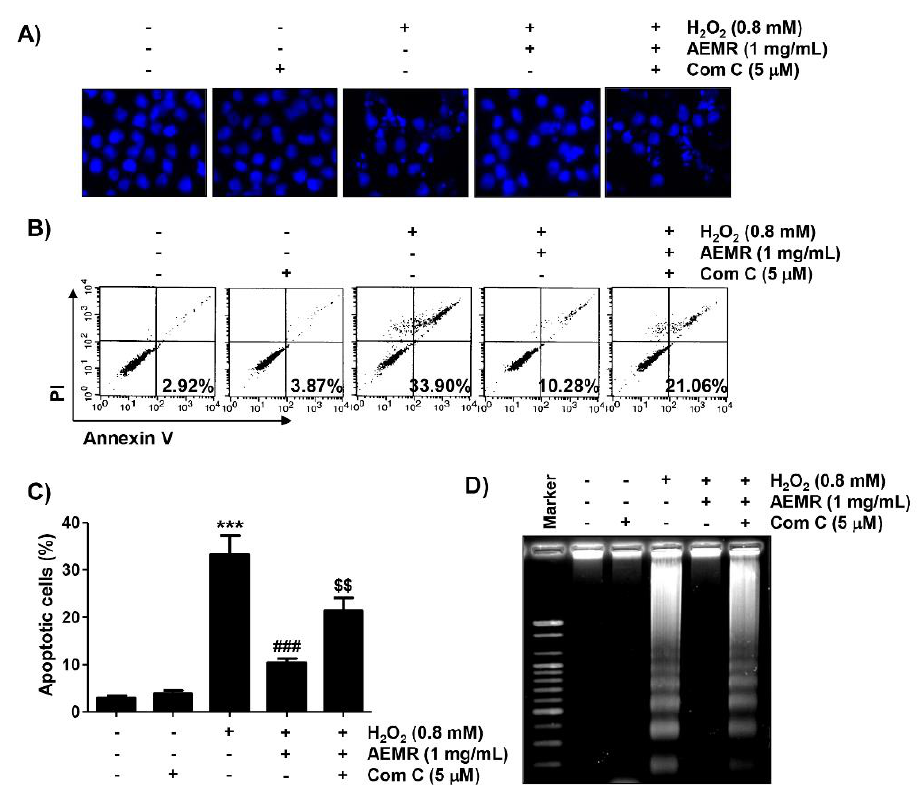
Figure 6. Effect of HO-1 inhibitor on AEMR-mediated protection of apoptosis by H 2 O 2 in C2C12 cells. Cells were pretreated with 5 μM compound C with or without 1 mg/mL AEMR for 1 h, and then treated with 0.8 mM H 2 O 2 for 24 h. ( A ) Induction of apoptosis was evaluated by measuring cells with condensed nuclei after 4 ′,6′ -diamidino-2-phenylindole (DAPI) staining. Representative photomicrographs are shown. ( B , C ) Cells were stained with annexin V/PI and then analyzed by flow cytometry. ( B ) Percentages of apoptotic cells are shown in lower right panels. ( C ) Quantitative analysis of apoptotic cells in percentage, including early and late apoptotic cells. Each point is the mean ± SD of independent triplicate experiments (*** p < 0.001 vs. control cells; ### p < 0.001 vs. H 2 O 2 -treated cells; $$ p < 0.01 vs. H 2 O 2 and AEMR-treated cells). ( D ) Fragmentation of genomic DNA isolated from cells was evaluated by agarose gel electrophoresis. 2.7. The Protective Effect of AEMR against Dexamethasone-Induced Muscle Atrophy in Rats To evaluate the effect of AEMR in vivo, we investigated the effect of oral administra- tion of AEMR on dexamethasone (DEX)-induced muscle atrophy in Sprague-Dawley rats. As shown in Figure 7A, body weight was significantly decreased following DEX